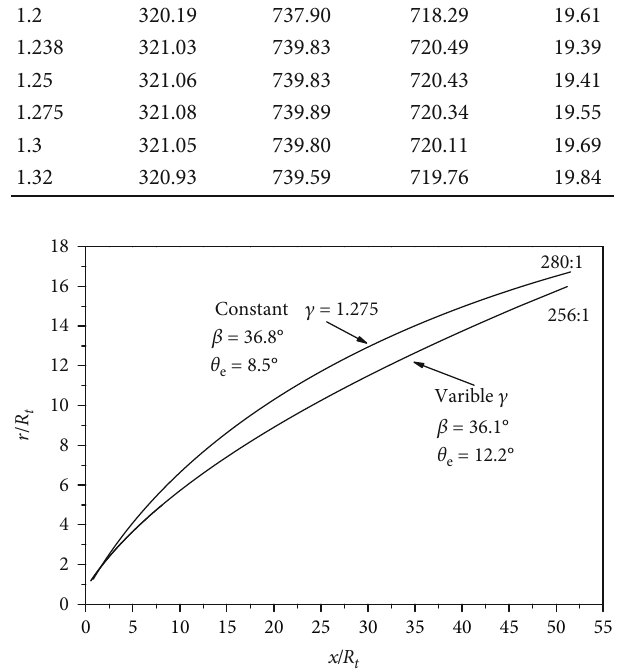
Figure 7: Comparison of contours designed with constant and variable γ .